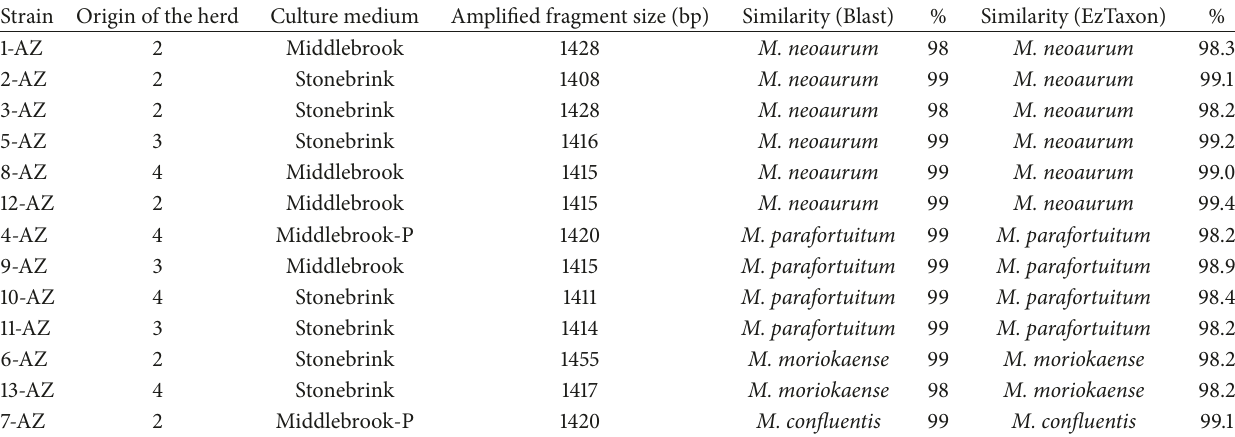
Table 3: Comparison of 16S rRNA gene sequences of strains isolated from cattle with those documented in GenBank, using BLAST and EzTaxon. Strain Origin of the